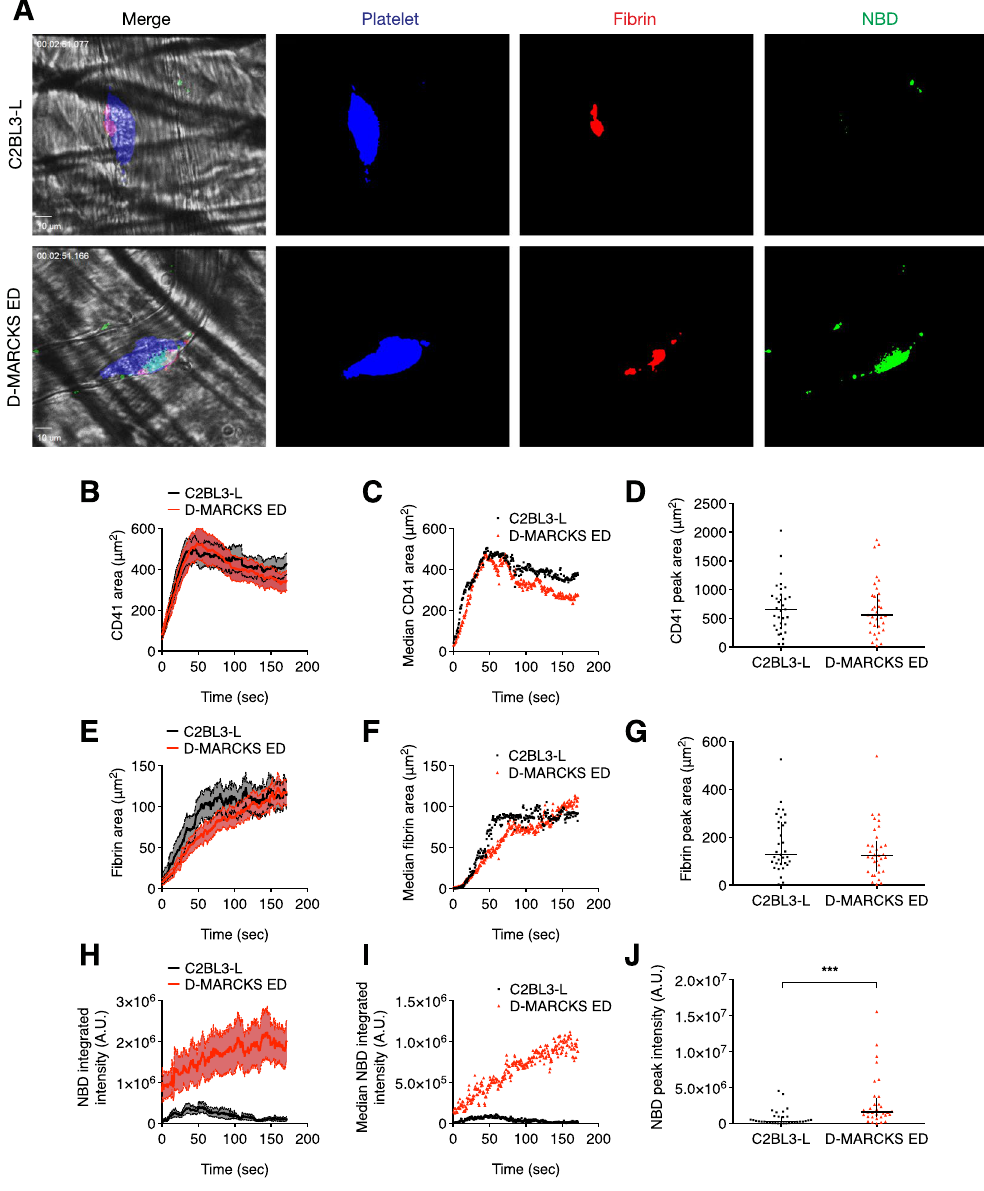
Figure 4. D-MARCKS ED binds to thrombi in vivo . ( A ) Representative fluorescence and bright field images of platelet accumulation (blue, anti-CD41), fibrin formation (red, anti-fibrin), and peptide binding (green, NBD-peptide) in the murine intravital laser-induced microvascular injury model when treated with 5 mg kg − 1 negative control C2BL3-L or D-MARCKS ED. Scale bar, 10 μ m. ( B – J ) Platelet area, fibrin area, and peptide NBD integrated fluorescence intensity accumulation following murine intravital microvascular injury when treated with 5 mg kg − 1 C2BL3-L or D-MARCKS ED. Time course data is shown as mean ± SEM ( B , E , H ) and median ( C , F , I ) values. Peak platelet, fibrin, and NBD values ( D , G , J ) are shown as mean ± SEM ( n = 33 thrombi from 4 mice). *** P < 0.001 when compared by the Mann-Whitney statistical test ( D , G , J